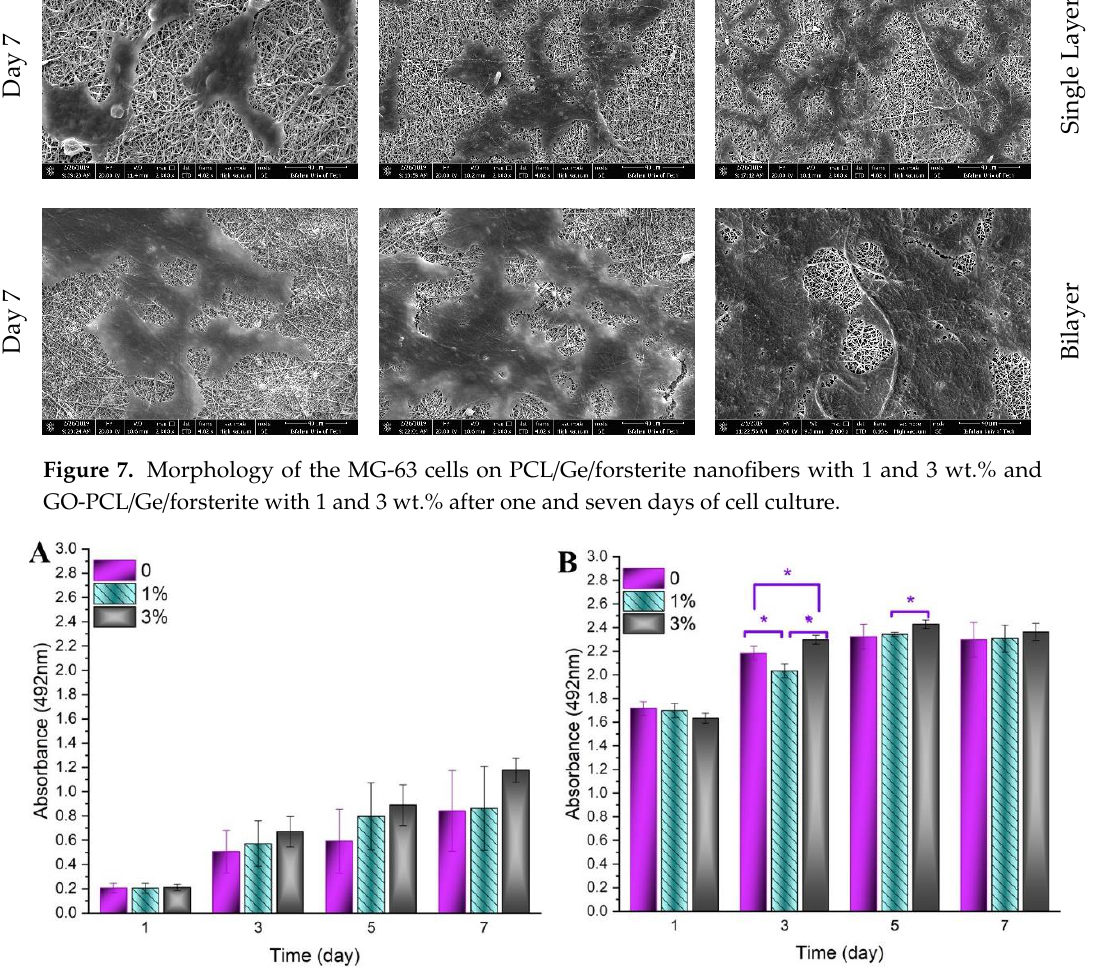
Figure 8. The MTS results of PCL/Ge structures containing 0, 1 and 3 wt.% forsterite nanoparticles, ( A ) without the GO layer and ( B ) with the GO layer (*significant difference at p value < 0.05).